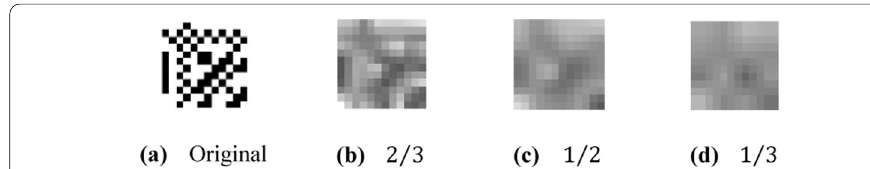
Fig. 2 When an a original texture pattern image is resized to b 2 / 3 , c 1 / 2 , and d 1 / 3 of its original size, it becomes blurred. The size of the texture pattern is 12 × 12 . Each dot in the figure represents a pixel